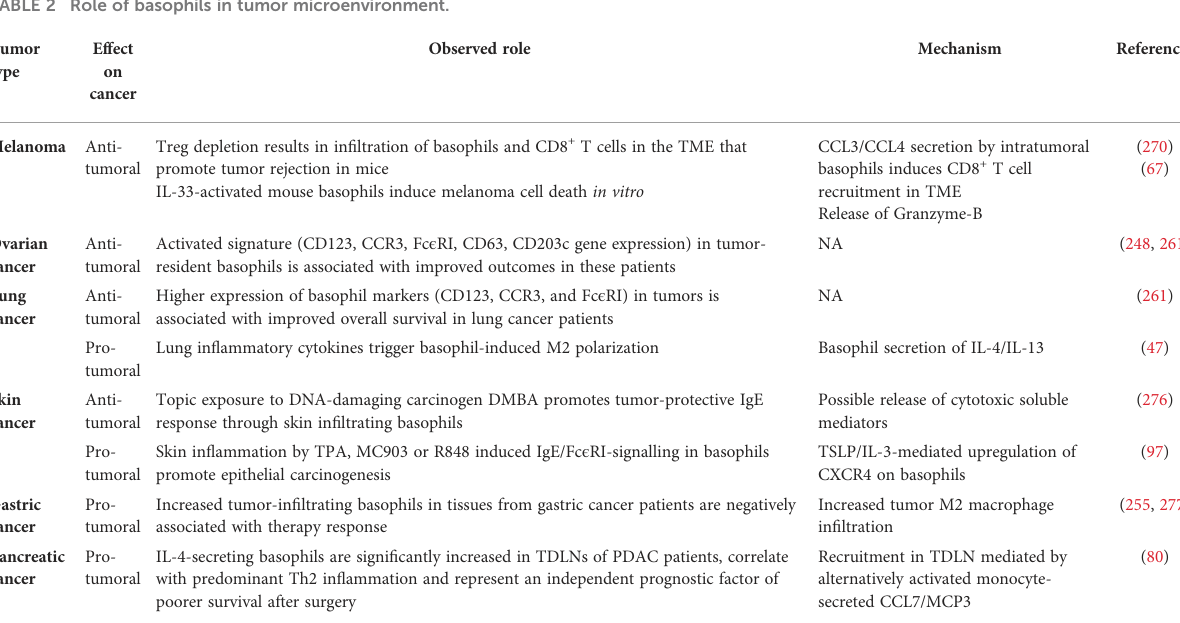
TABLE 2 Role of basophils in tumor